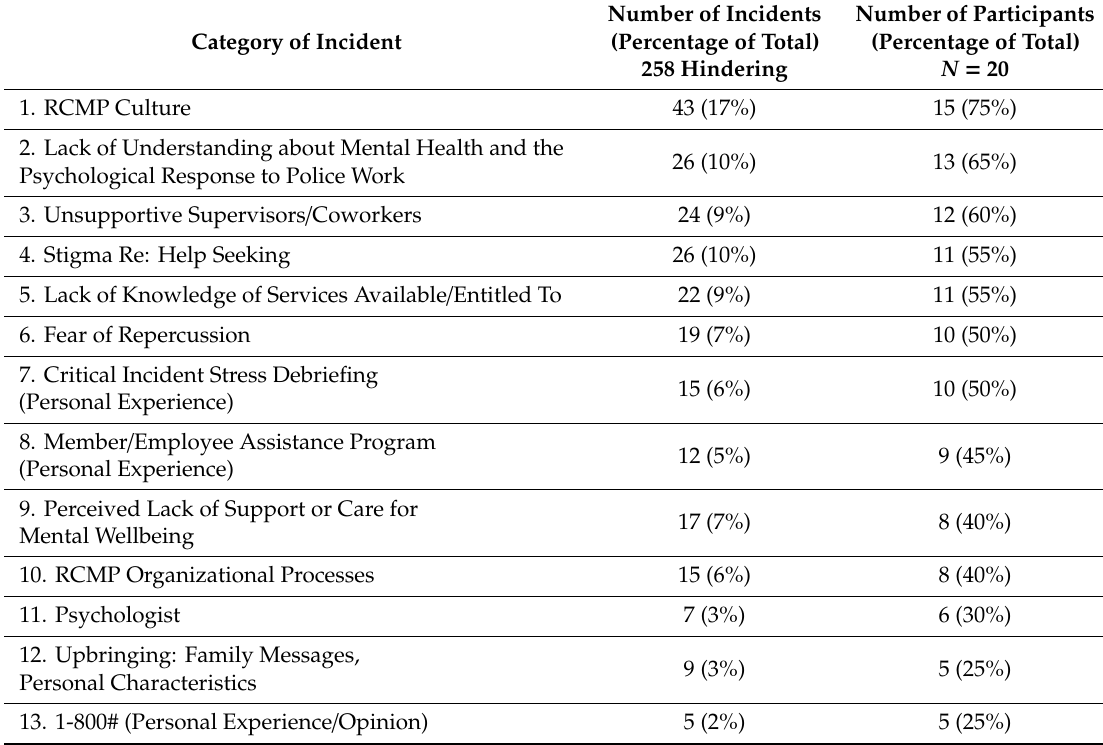
Table 2. Incidents That Hinder the Decision to Access Psychological